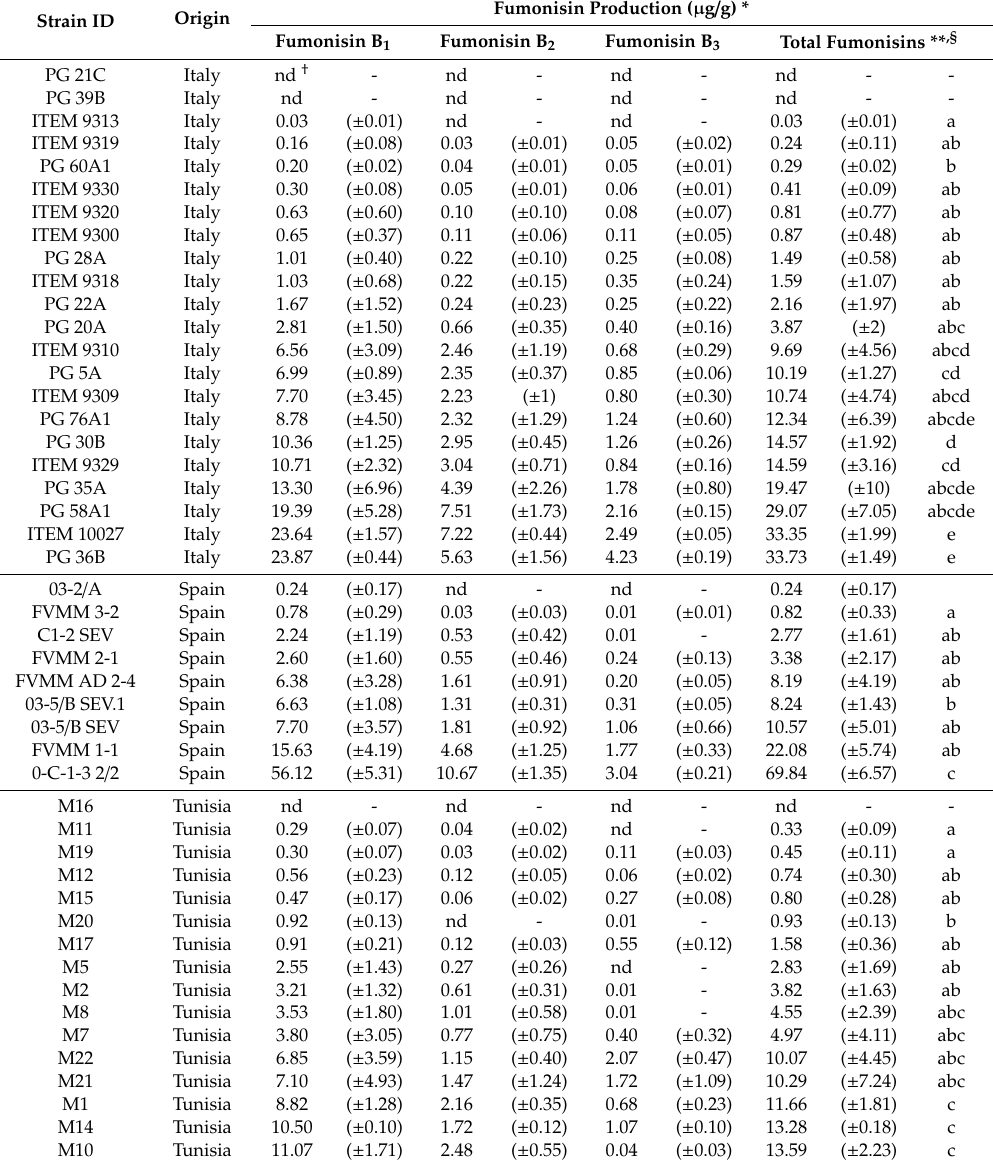
Table 1. Strain ID, country of origin and fumonisin B 1 , fumonisin B 2 and fumonisin B 3 production ( µ g / g) with standard errors ( ± SE) by Fusarium verticillioides strains isolated from maize kernels harvested in five Mediterranean countries and analyzed in this